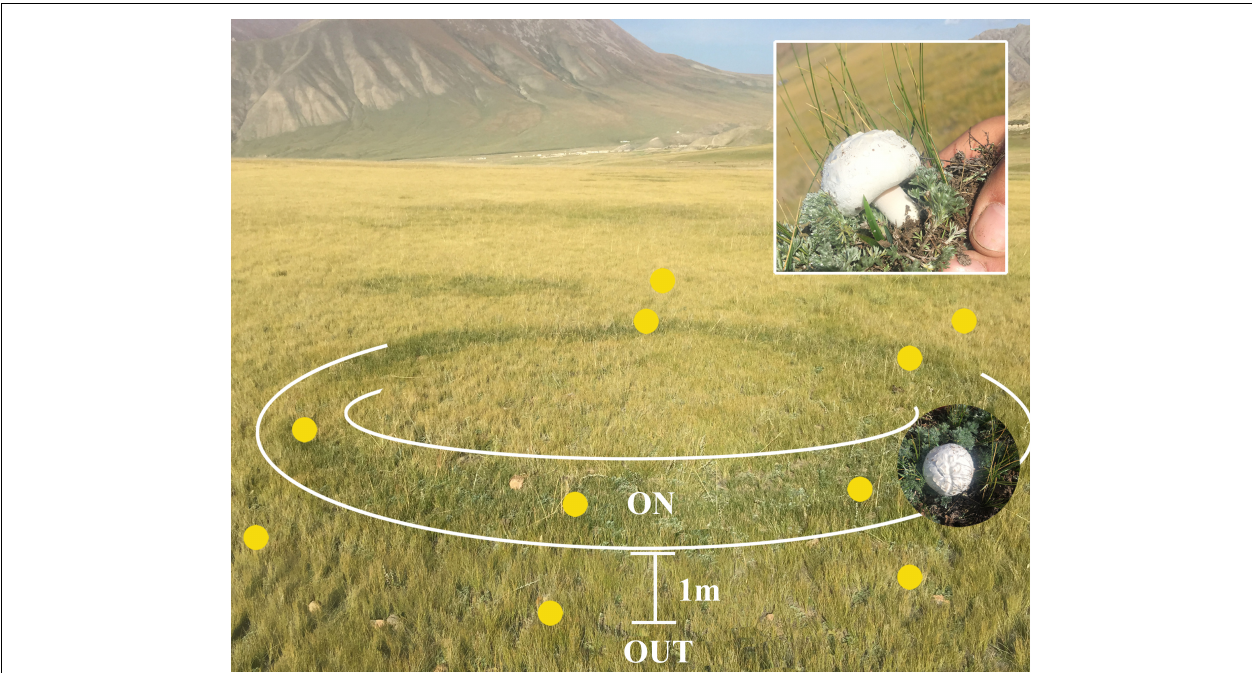
FIGURE 1 | Distribution diagram of soil sampling points from Leucocalocybe mongolica fairy ring. ON, the zone located in plant belt that flourishing growth and beneath the fairy ring; OUT, the zone far away from ON zone about 1 m and out of fairy ring, that was not affected by fairy ring fungi. The insert pictures, Leucocalocybe mongolica that was fairy ring-forming fungus, and grown in the ON zone.